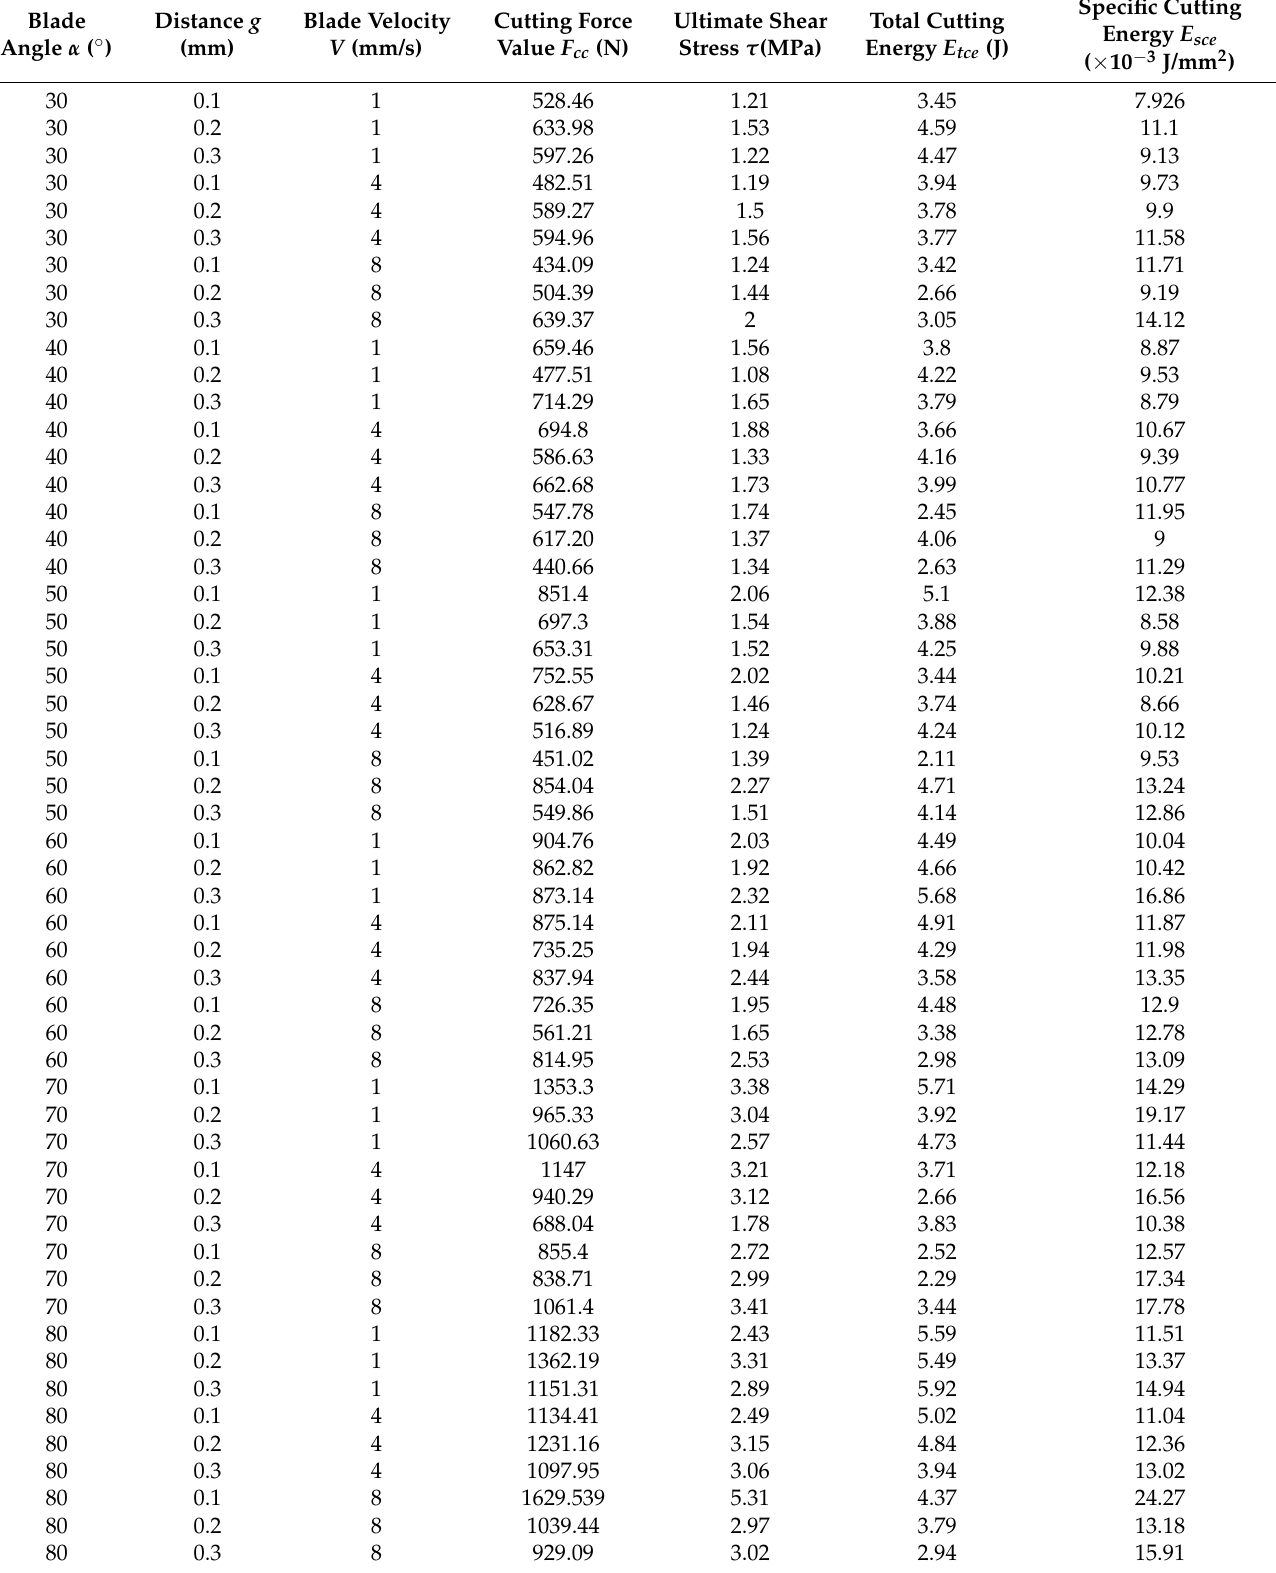
Table 2. List of corrected average (from ten tests) maximum values of the initial parameters of the experiment expressed as the corrected cutting force, F cc , shear stress, τ , total cutting energy, E sce , and total cutting energy, E tce , for respective experimental input